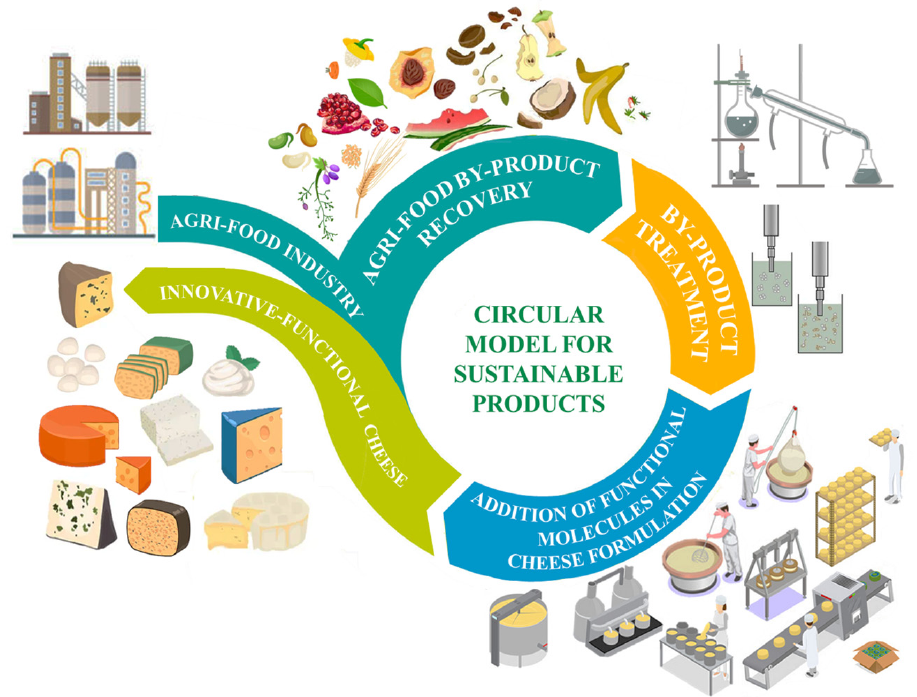
Figure 1. Circular model for sustainable products.